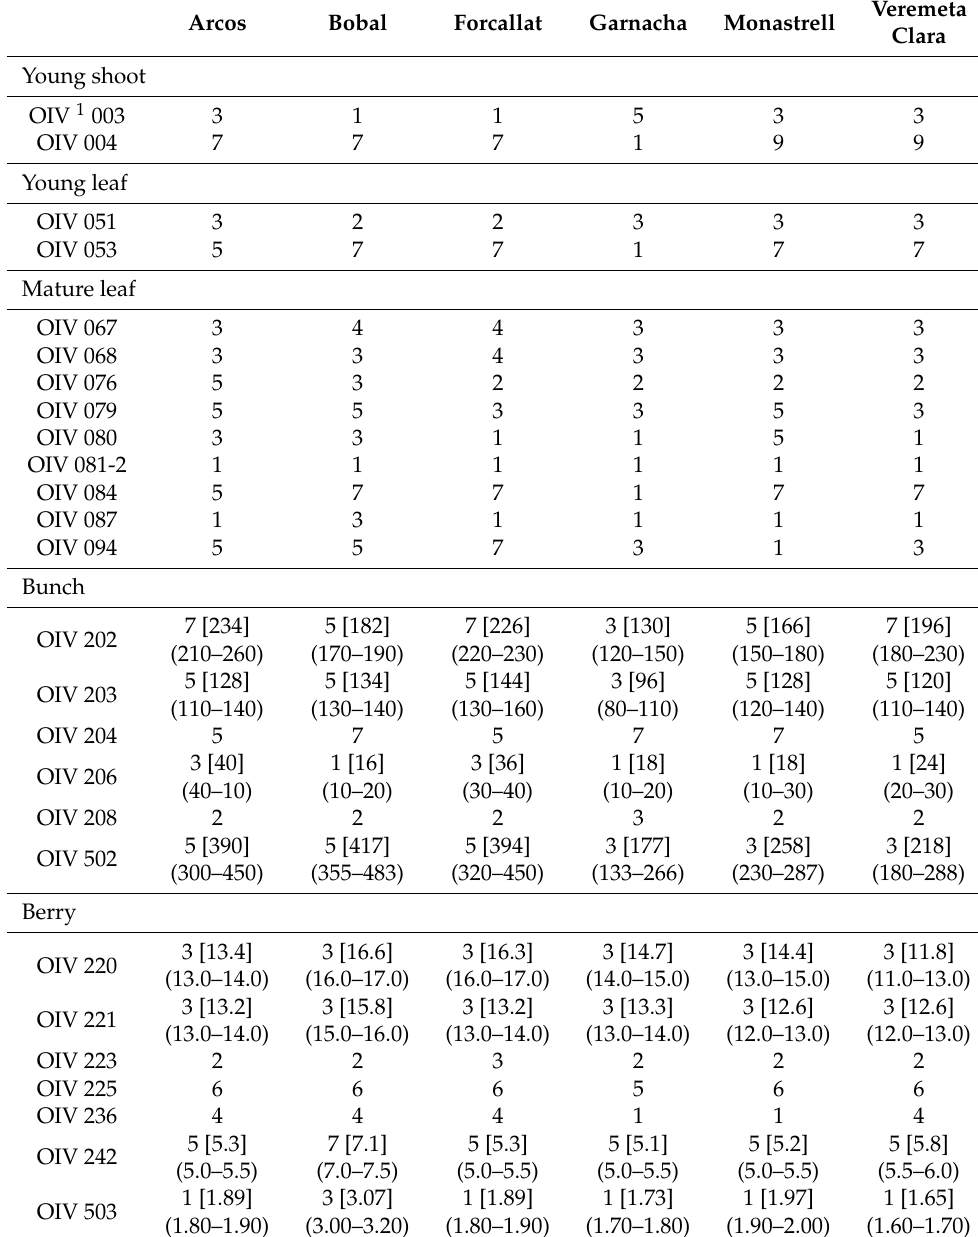
Table 1. Ampelographic traits of the varieties Arcos, Bobal, Forcallat, Garnacha, and Monastrell and its variant Veremeta growing in an old vineyard of